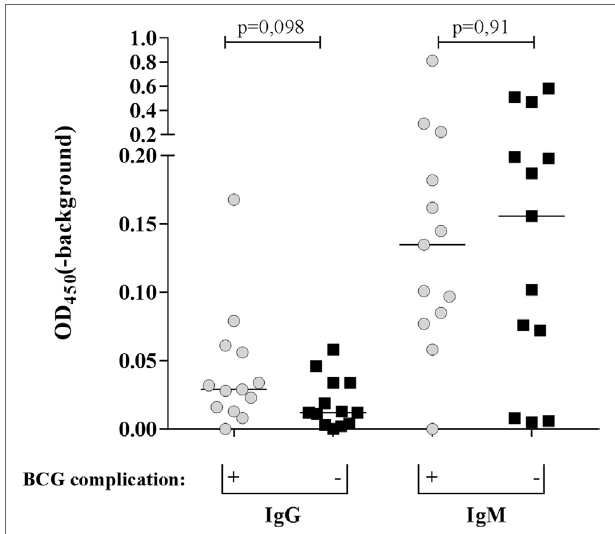
FiGUrE 2 | Mycobacterium leprae phenolic glycolipid-I (PGL-I)-specific antibodies in contacts of leprosy patients with or without BCG-induced skin complications. IgG and IgM antibodies directed against synthetic PGL-I (ND–O–HSA) were determined by ELISA. Samples with OD 450 (corrected for background OD) > 0.2 were considered seropositive. No statistically different levels of IgG and IgM antibodies were observed between the contacts with ( + ; gray dots) or without ( − ; black squares)